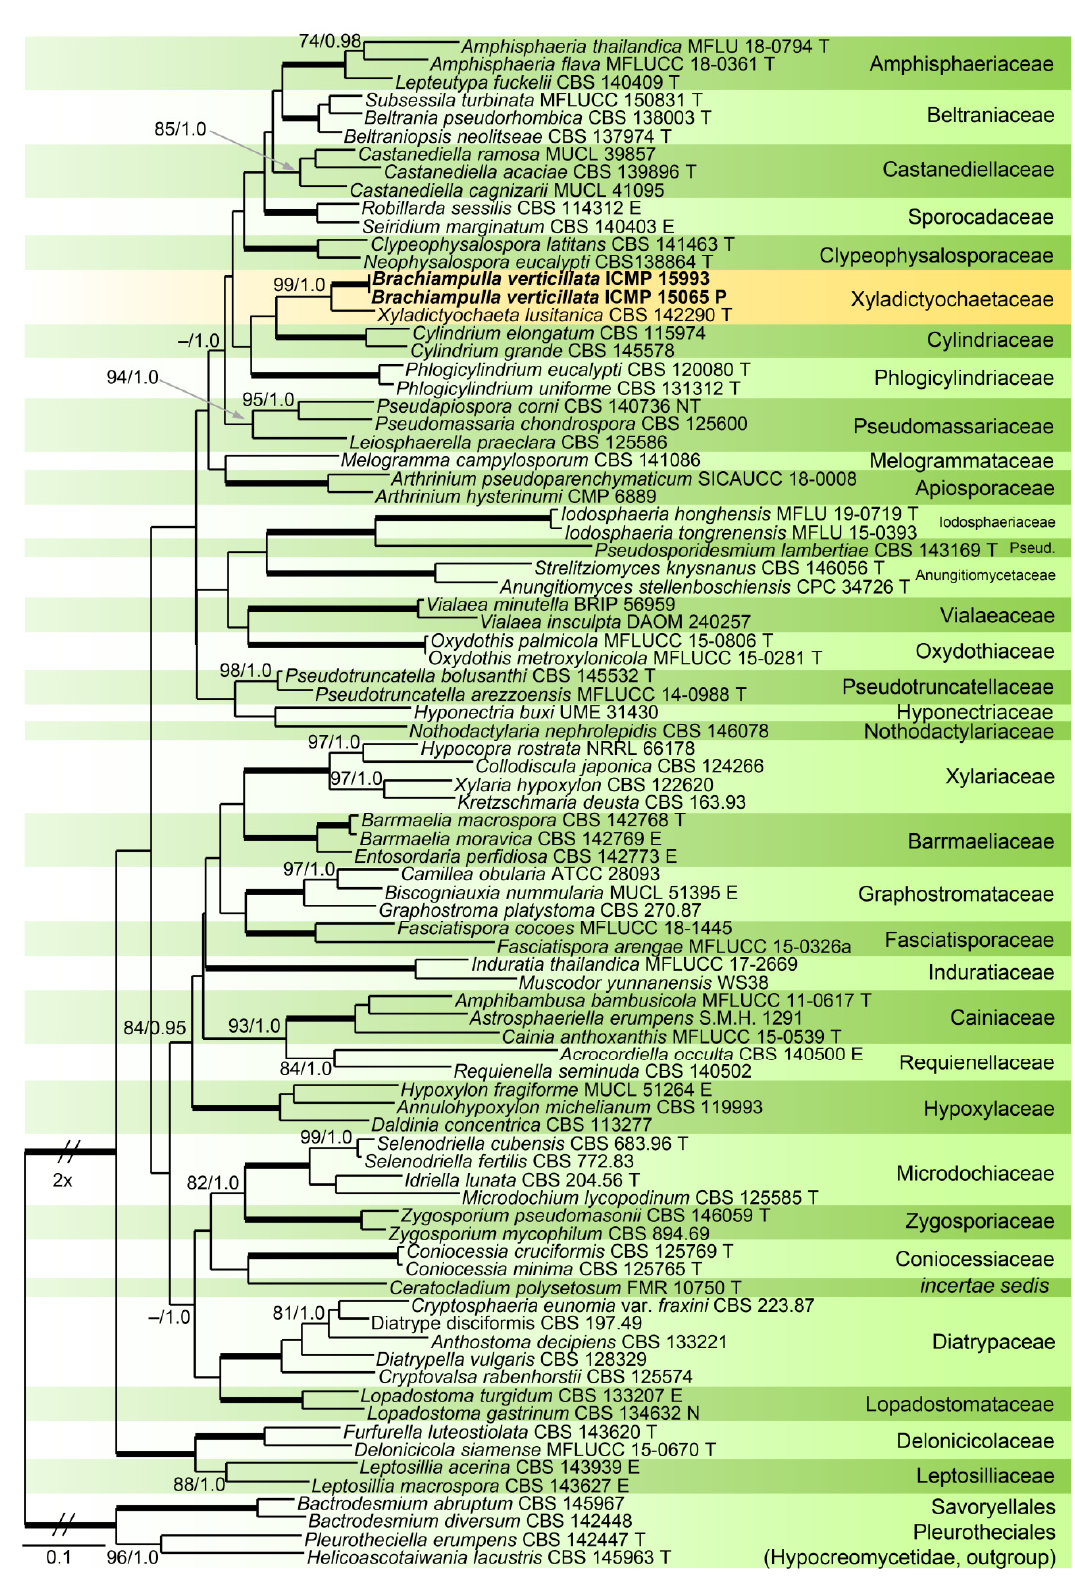
Figure 4. Combined phylogeny of ITS, 28S, tef1- α and rpb2 sequences of selected members of the Xylariales. Species names given in bold are taxonomic novelties; T, E, N and P indicate ex-type, ex-epitype, ex-neotype and ex-paratype strains. Thickened branches indicate branch support with ML BS = 100%, PP values = 1.0. Branch support of nodes ≥ 75% ML BS and ≥ 0.95 PP is indicated above or below branches. Abbreviation: Pseud. (Pseudosporidesmiaceae).